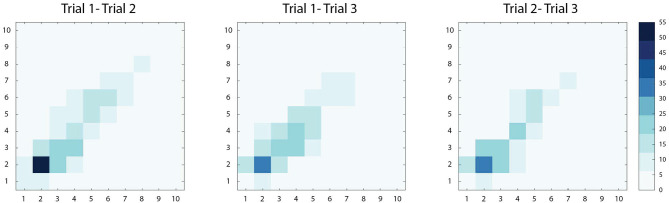
Bivariate density plots demonstrating within-subject agreement between two PS score measurements (scored 1–10). Increased agreement between two measures is demonstrated with increasing color intensity. Among the three comparisons, Trial 1-2, Trial 1-3, and Trial 2-3, the majority of paired observations lie along the diagonal, suggesting strong agreement. Across the diagonal, the greatest intensity is observed in the lower scores (PS score<5), where the majority of scores were observed in this study.